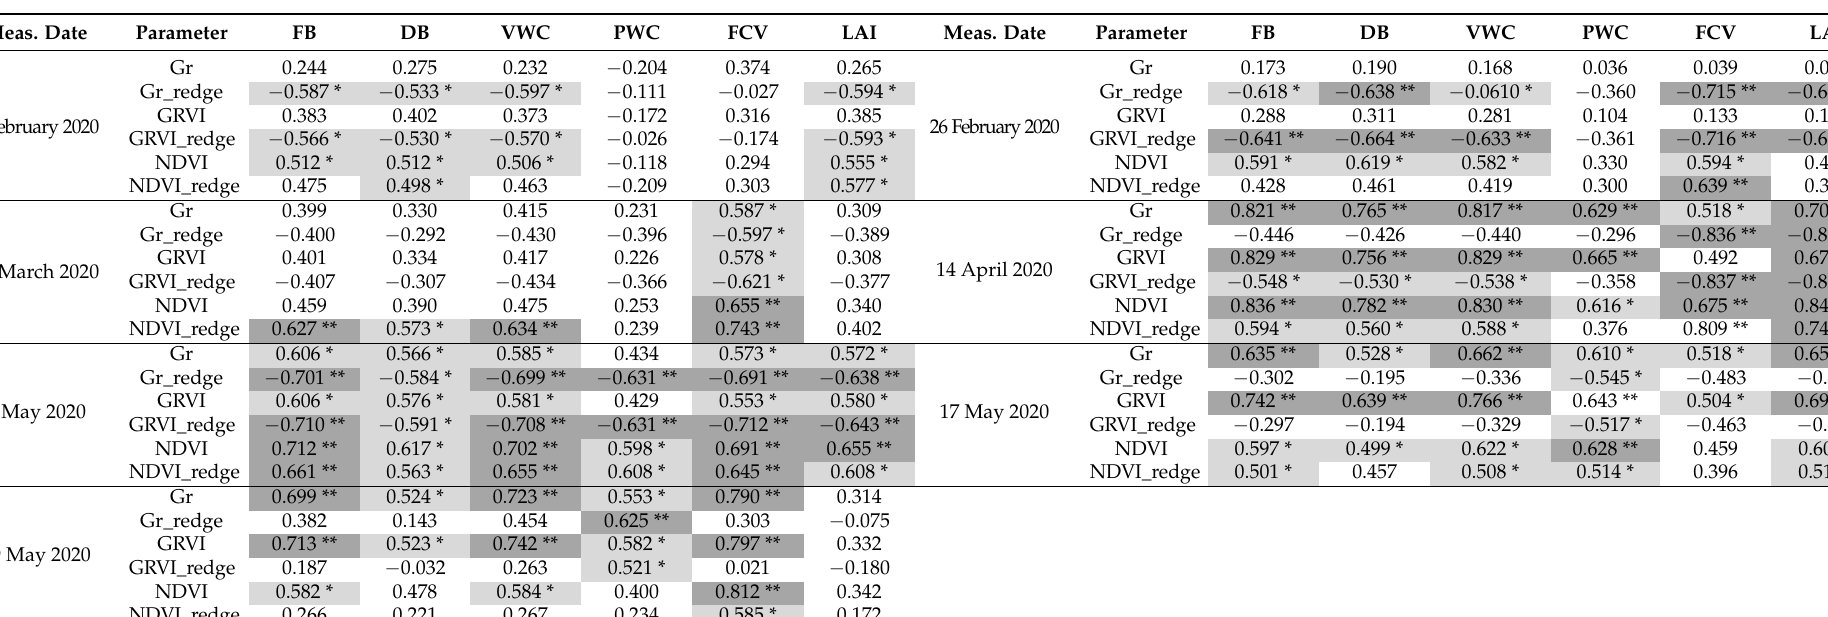
Table A1. Correlations ( n = 16) at each date between field measurements and spectral indices of the eight associations in a whole (Pearson Correlation Coefficient). Meas.